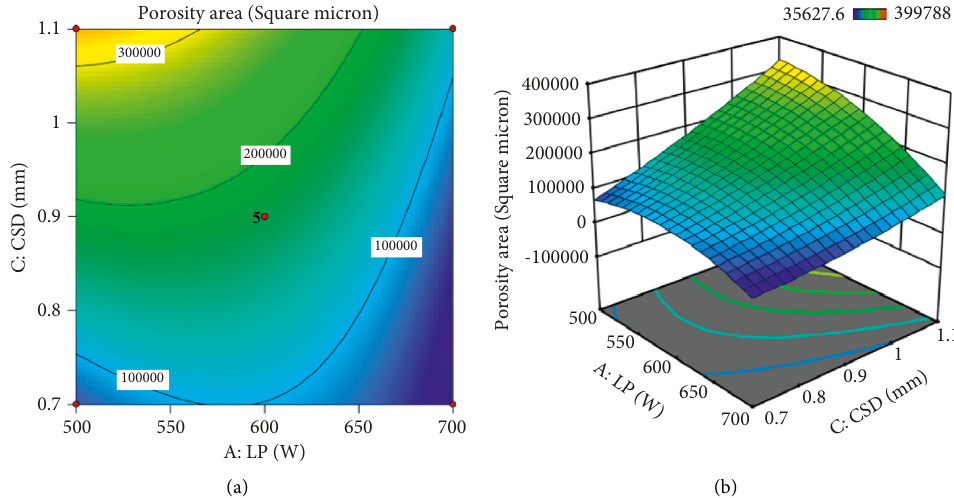
Figure 7: Effect of the interaction between the laser power and the cladding step on the porosity area: (a) contour map; (b) three- dimensional response